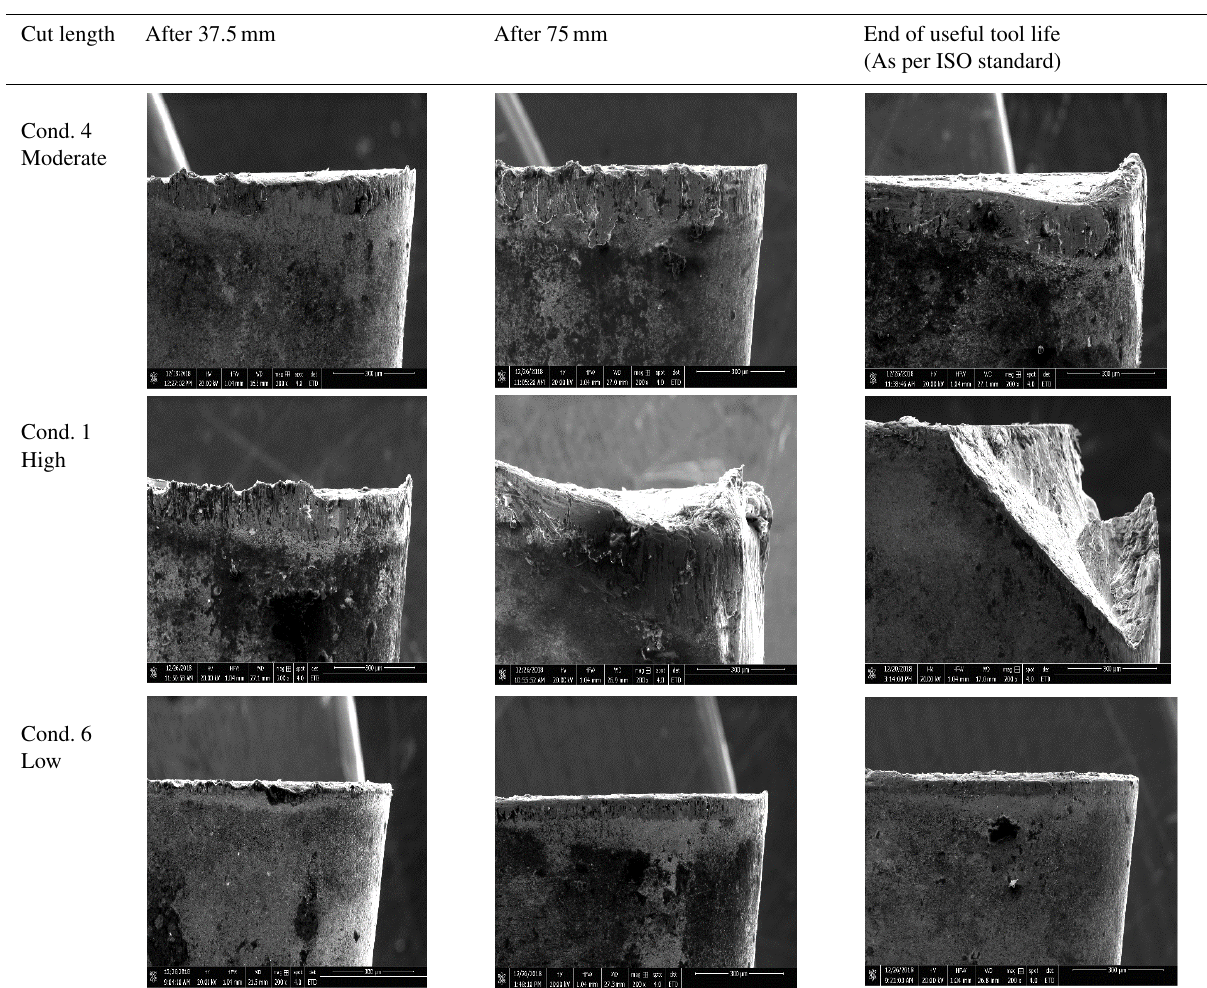
(As per ISO standard)